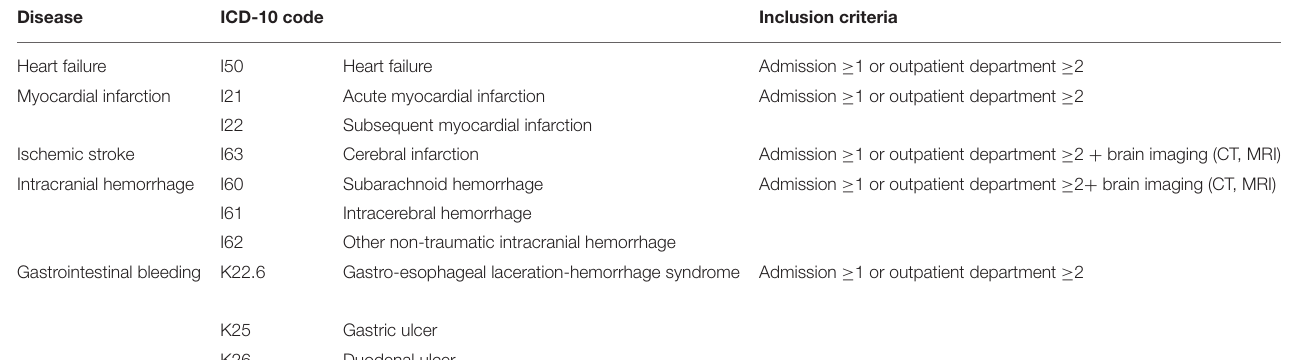
TABLE 2 | Definition of health event (ICD-10).